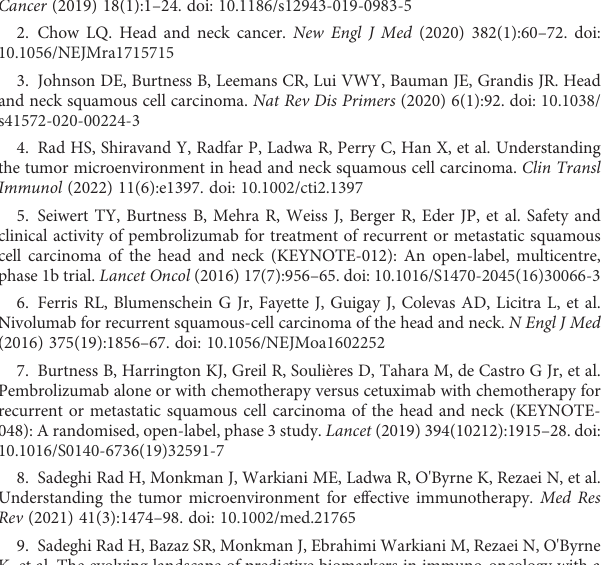
SUPPLEMENTARY FIGURE 5 Identi fi cation of patients ’ subgroup with overall survival associations. Multivariate COX proportional hazard analysis is conducted to show the hazard ratio with 95% con fi dence interval for different subgroup of patients. HR>1 indicates association with poorer outcomes.